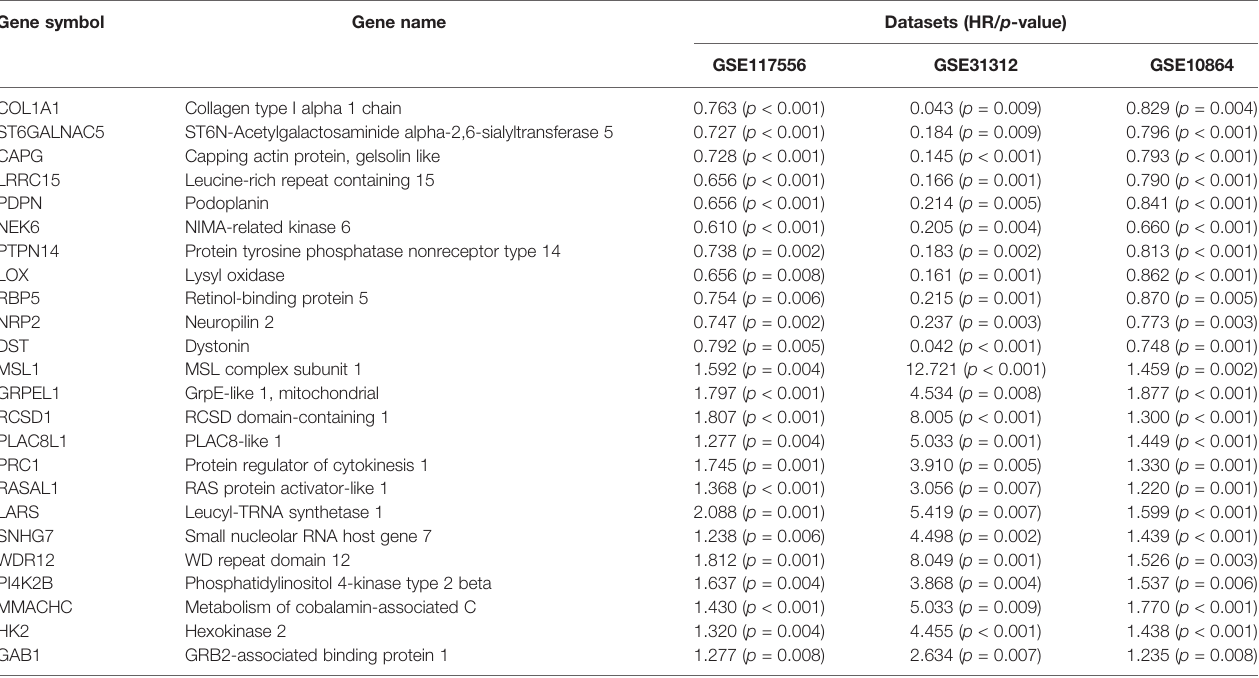
TABLE 2 | Detail information of selected common genes in three datasets. Gene